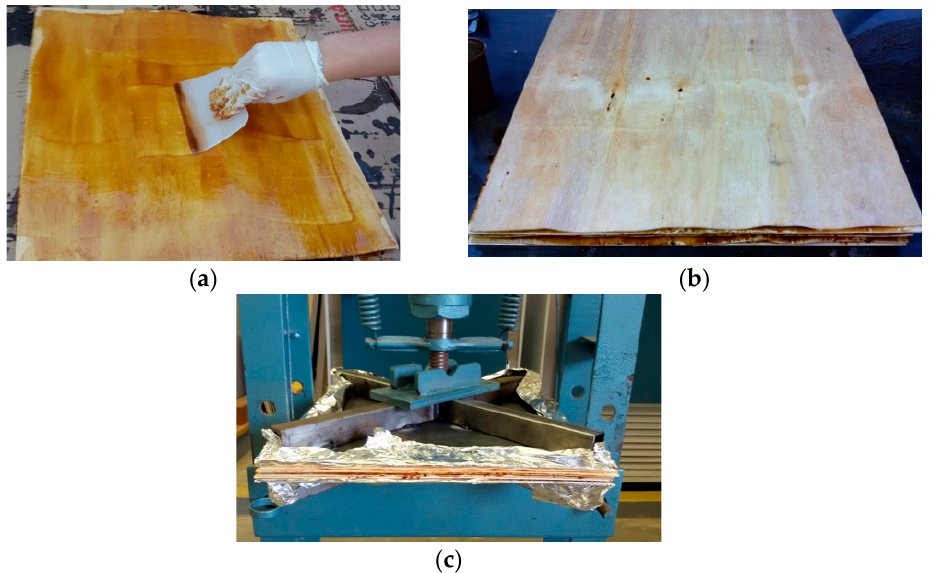
Figure 2. Plywood production. ( a ) Adhesive application, ( b ) seven veneers arrangement and ( c ) cold pressing.